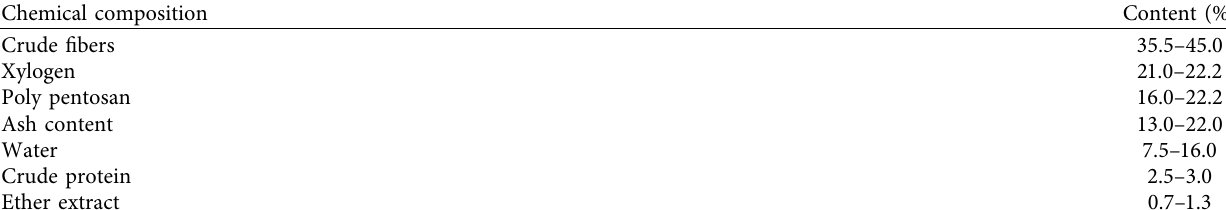
Table 1: Chemical composition of rice husks (%).